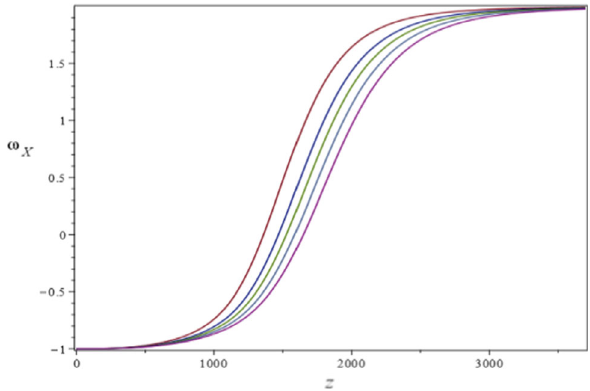
Fig. 1 The evolution of equationof stateof dark energy versus redshift for different values of Rényi parameter α ∼ 10 2 − 10 2 . 25